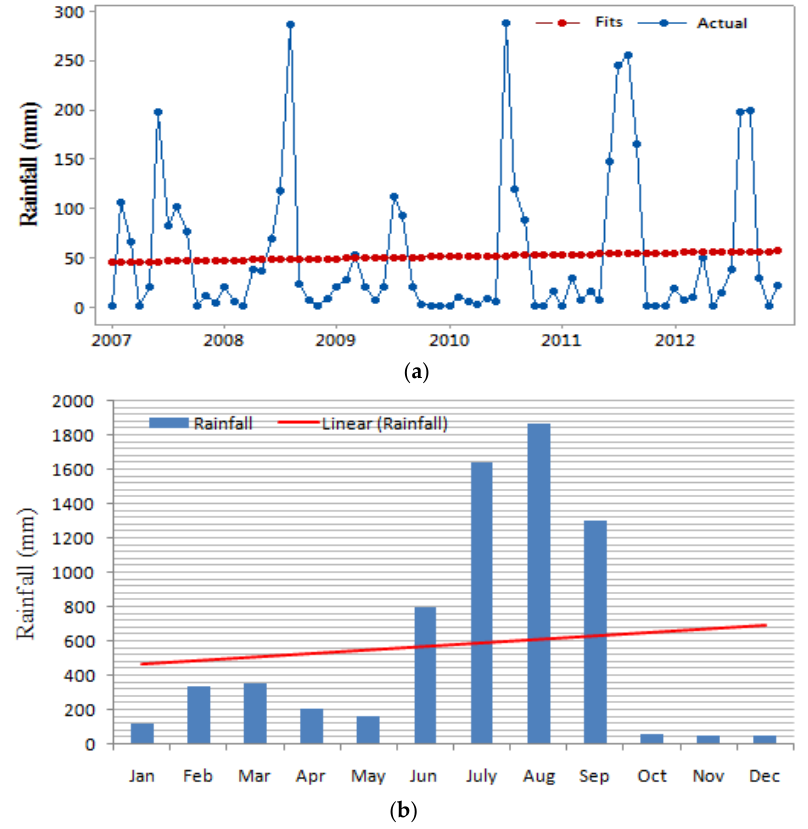
Figure 6. ( a ) Monthly time series of rainfall in Lahore City, 2007–2012. ( b ) Seasonal time series of rainfall in Lahore City, 2007–2012 .